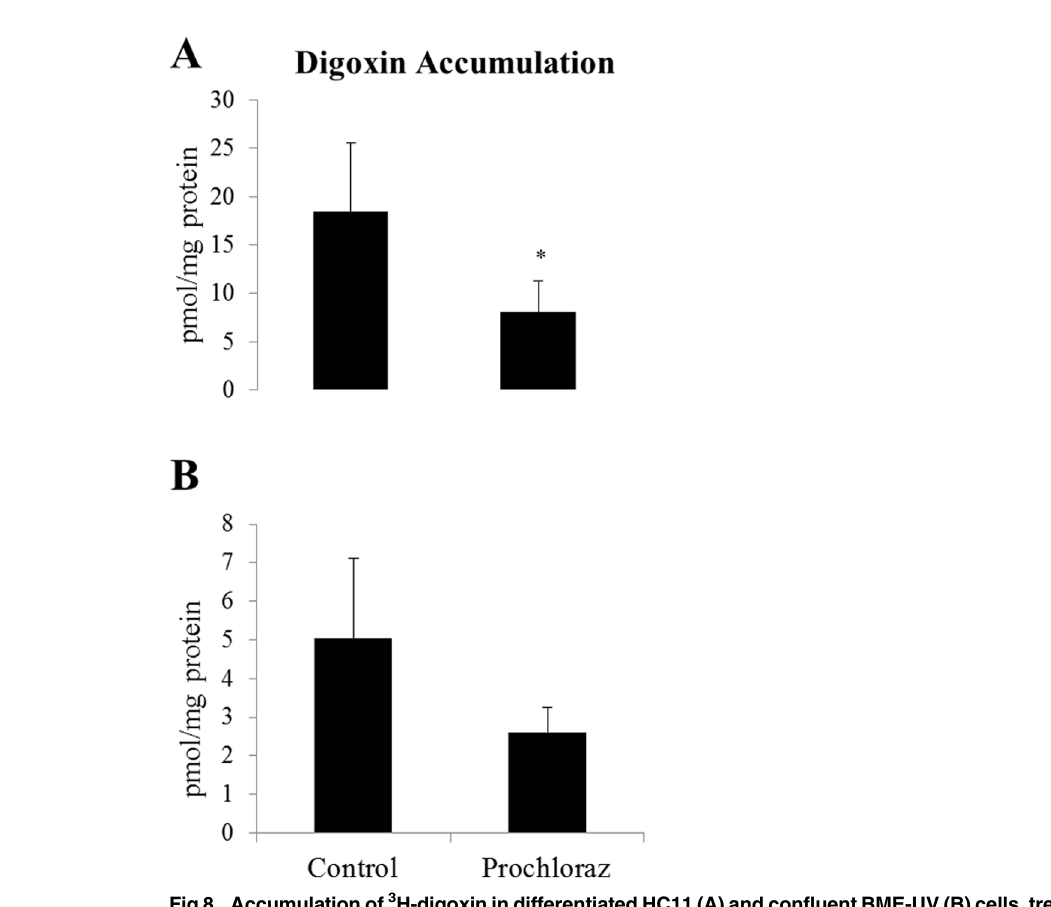
Fig 8. Accumulation of 3 H-digoxin in differentiated HC11 (A) and confluent BME-UV (B) cells, treated with 30 μ M prochloraz for 24 h. The data is presented as means ± SD of 3 – 4 samples and expressed as pmol mitoxantrone/mg cellular protein. Statistically significant differences between groups, * p (cid:1) 0.05.